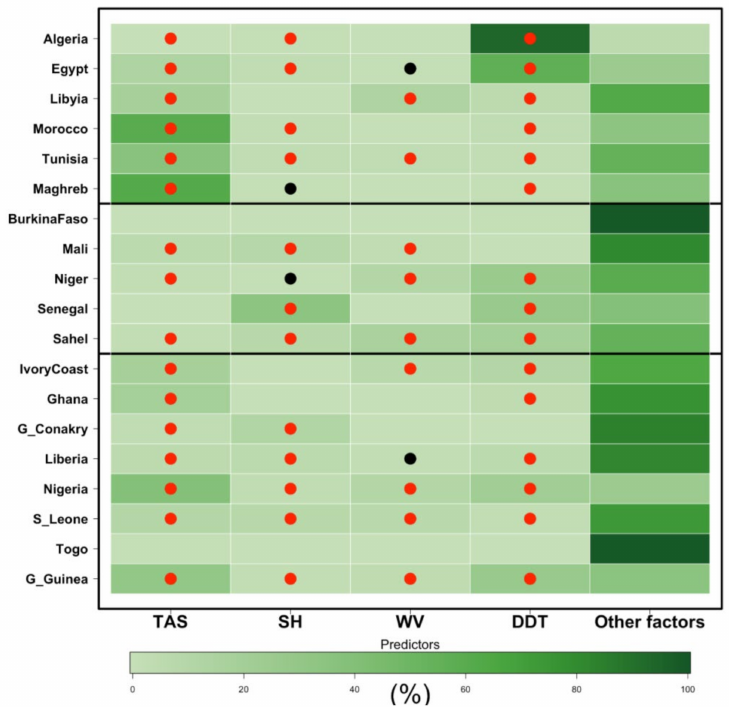
Figure 8. Relative proportion of variance explained, i.e., the contribution of each potential explanatory covariates predicting the COVID-19 pandemic transmission. TAS, SH, and WV represent the temper- ature, specific humidity, and water vapor climate variables. At the same time, “DDT” and “Other factors” refer respectively to the dynamics of the disease transmission (DDT) and the non-climatic factors such as socio-economic, epidemic response, demographic, and geographic factors. Due to a lack of sufficient data in the considered countries, these non-climatic factors were not modeled. Significant contribution with 99% confidence intervals, that is, the proportion of variance explained that is significant at 0.01 level (i.e., p < 0.01; 99% CI), is reported in red dot, while the proportion of variance explained that is significant at 0.05 level (i.e., p < 0.05; 95% CI), is reported in black